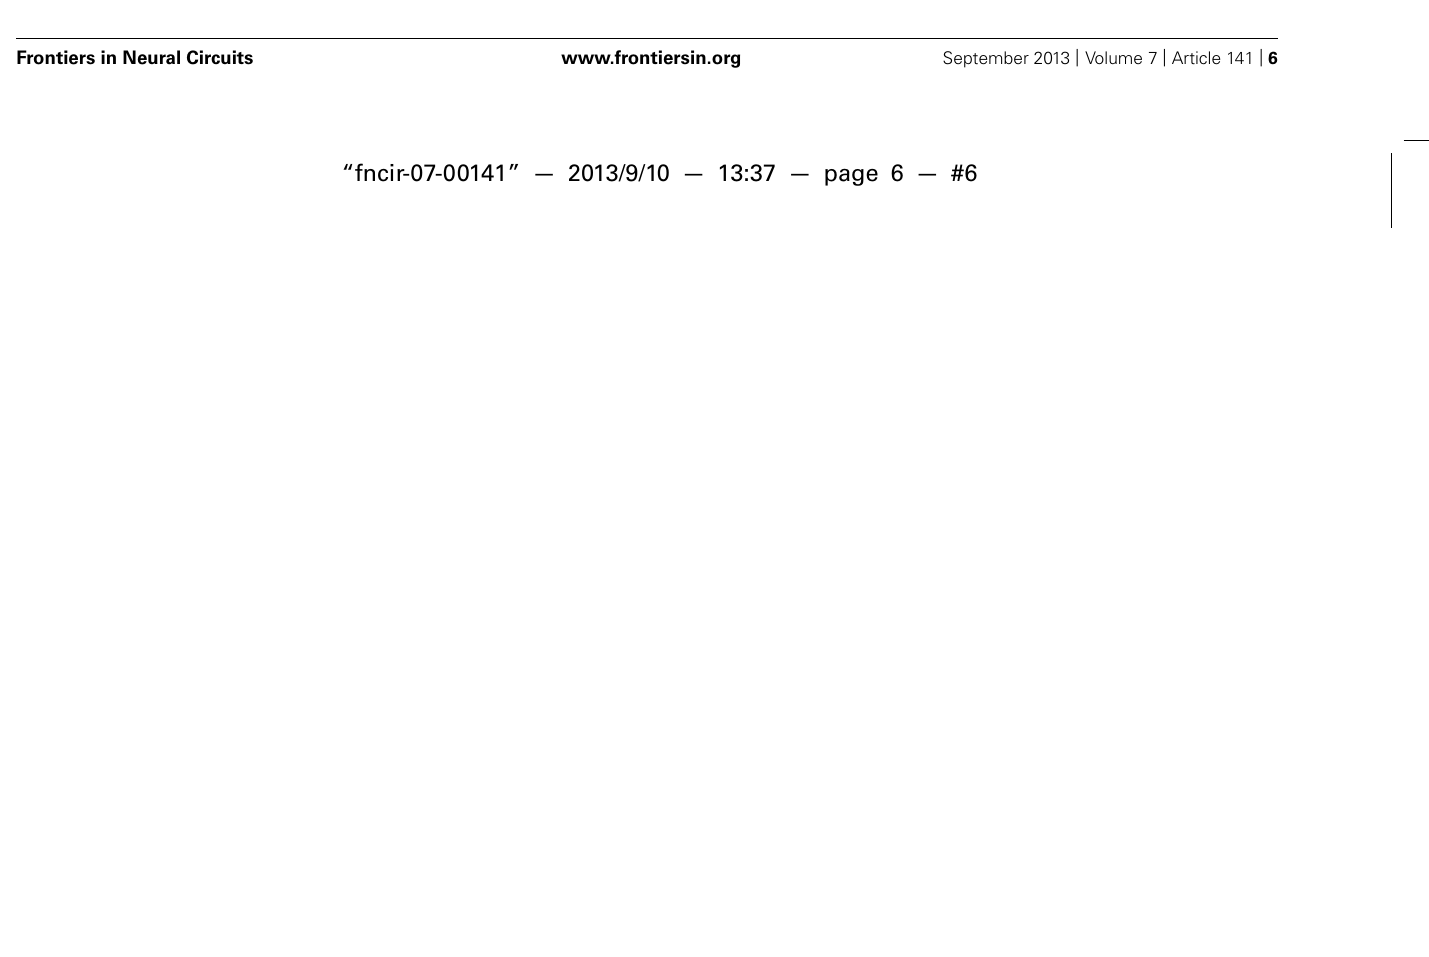
(left) and SNAP-5114 (right) for multiunit action potential rates. All data are normalized to the control condition (absence of drug). Open gray circles are data from individual experiments, filled black circles and error bars represent means and sd, respectively. Smooth black line connecting the means represents a Hill fit to the NO-711 data. Gray dashed lines represent IC 50 values. (C) Concentration–response curves of NO-711 (left) and SNAP-5114 (right) for the proportion of time spent in bursts. All conventions as in (B)